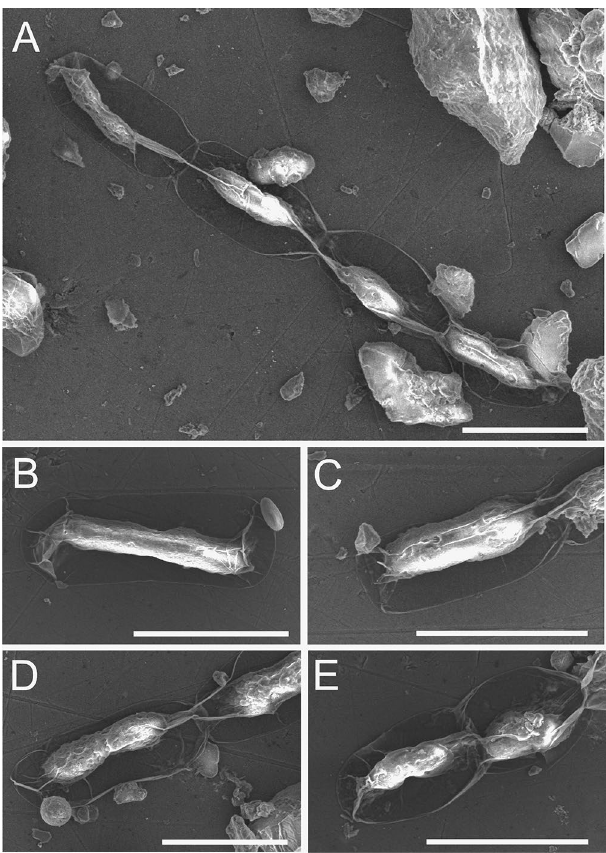
Figure 5. SEM images of fixed A. nordenskioeldii from Upper Foxfonna Glacier (elevation 789 m): A—chain of connected cells B-E—image of single and doublet cells; the cell wall is very thin, delicate, and shrinks easily. The images were taken immediately after placing the samples in the acetone solution in the microscope chamber to minimize the negative effects of drying. The scale bar corresponds to 20